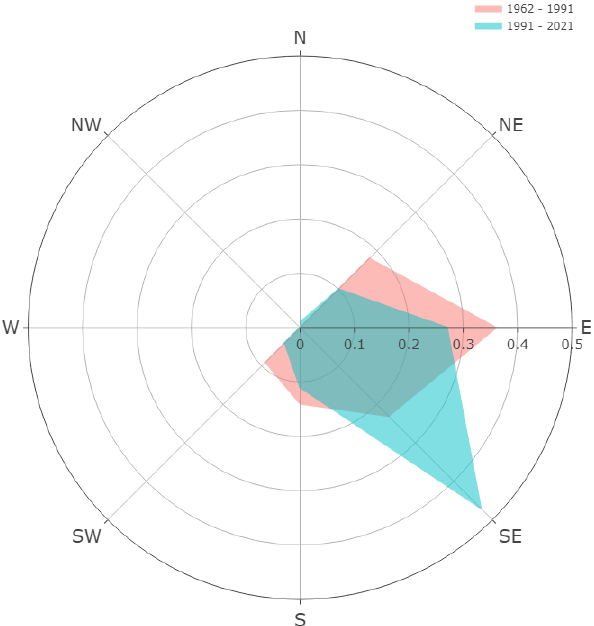
Figure 4. The avalanche occurrence distribution per path orienta- tion for wet-snow avalanches. Radial axis represents the avalanche proportion for each cardinal